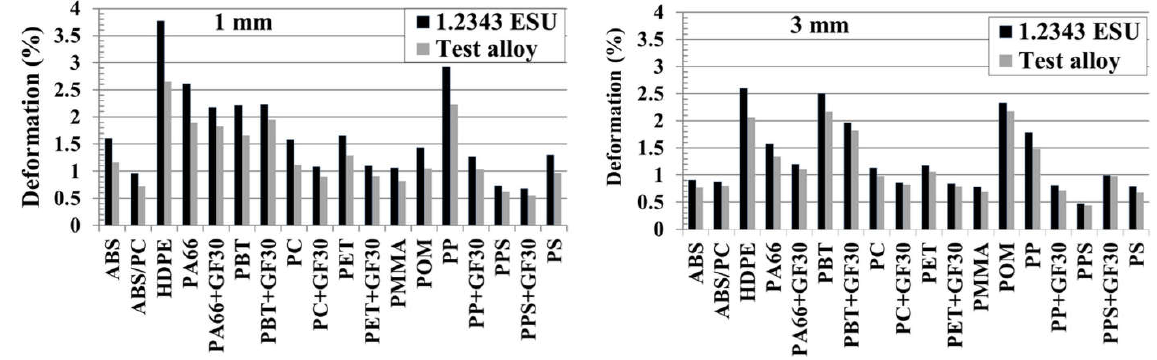
Figure 11. Part warpage (deformation) for test alloy compared to 1.2343 ESU for different polymers and two wall thicknesses (left: 1 mm, right: 3 mm).